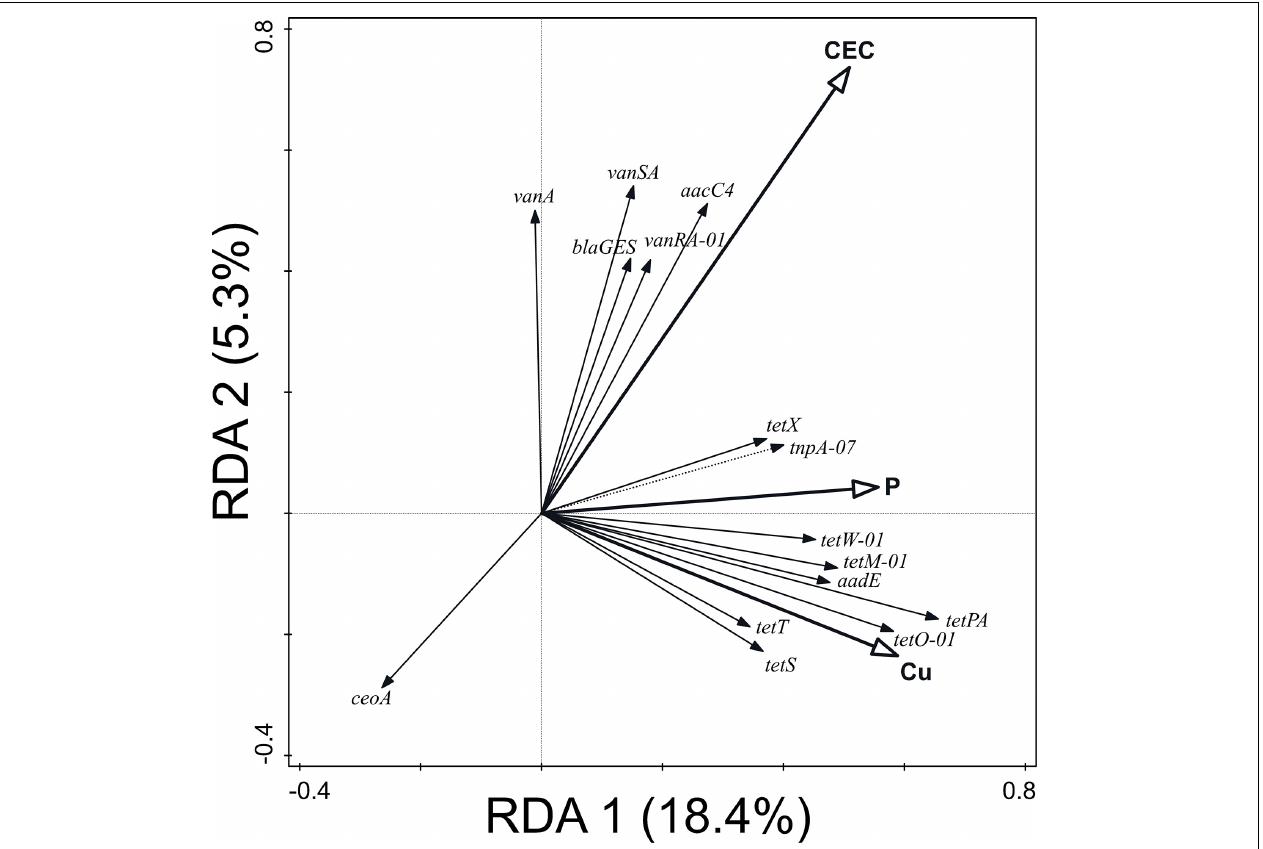
FIGURE 4 | Biplot of the RDA performed with soil physicochemical properties (explaining 43.3% of the variation in ARG and MGE-gene relative abundances) as explanatory variables, the relative abundance of ARGs and MGE-genes as response variables, and field and current crop as covariates. Only statistically significant explanatory variables and response variables with the best fit are